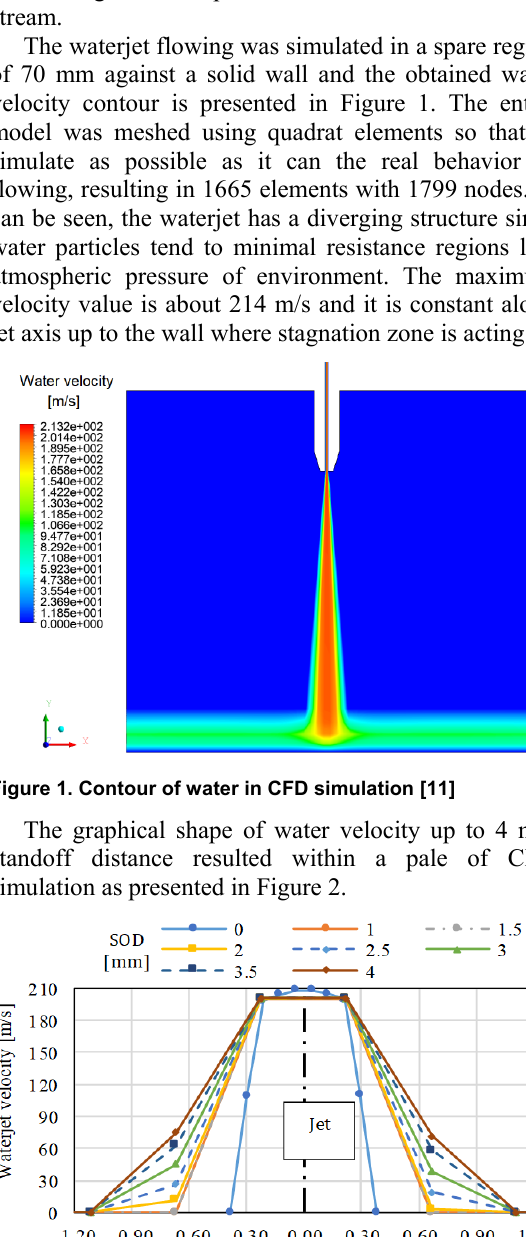
Figure 4 depictes the graphical representation of width kerf variation at the entrance of the jet through the